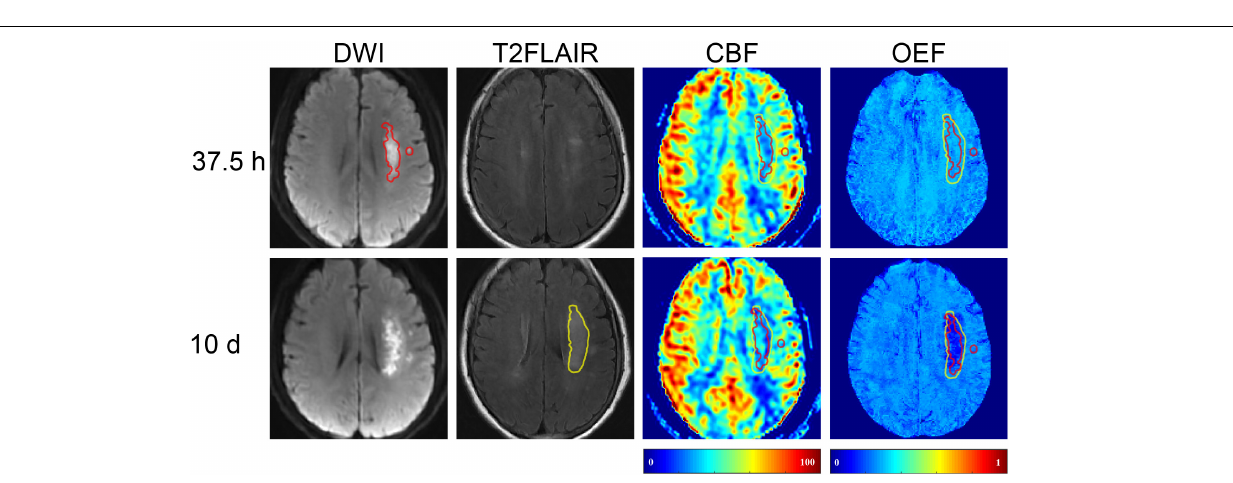
FIGURE 2 | Oxygen extraction fraction (OEF) of the infarcted area defined on DWI and the contralateral mirror area and their quotient [relative OEF, relative oxygen extraction fraction (rOEF)] in four ischemic stroke phases. (A) The OEF significantly reduced compared with the contralateral mirror area in all stroke phases (two-tailed paired t -test: p < 0.05 for all). Besides, the OEF showed a trend of decrease from the acute to the chronic phase and was statistically significant (ANOVA: p = 0.022). (B) The rOEF showed the same decreasing tendency with OEF (ANOVA: p = 0.024). The center line is the mean and the other two lines are the standard deviations. * p < 0.05, ** p < 0.01, and *** p < 0.001.